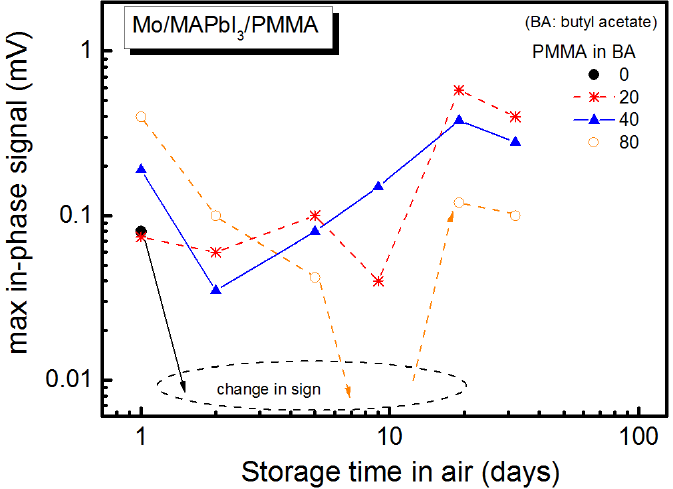
Figure 6 . Maximum in ‐ phase SPV spectra for the perovskite coated with PMMA at concentrations of 0, 20, 40, and 80 mg/mL stored in air on the 1st, 18th, and 43rd day.